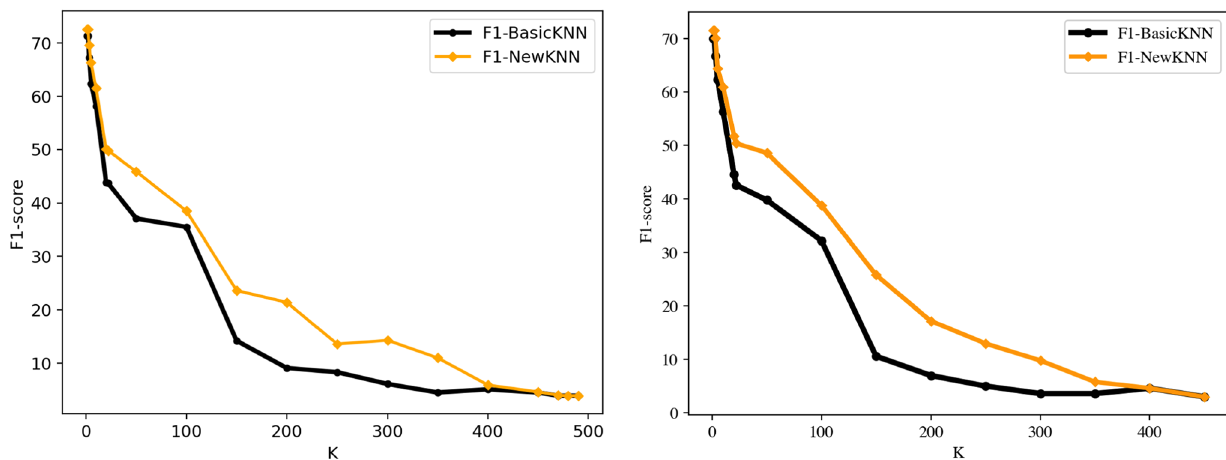
Fig. 3 F1-score evolution for KNN using Euclidean distance with tenfold and fivefold cross-validation on Products